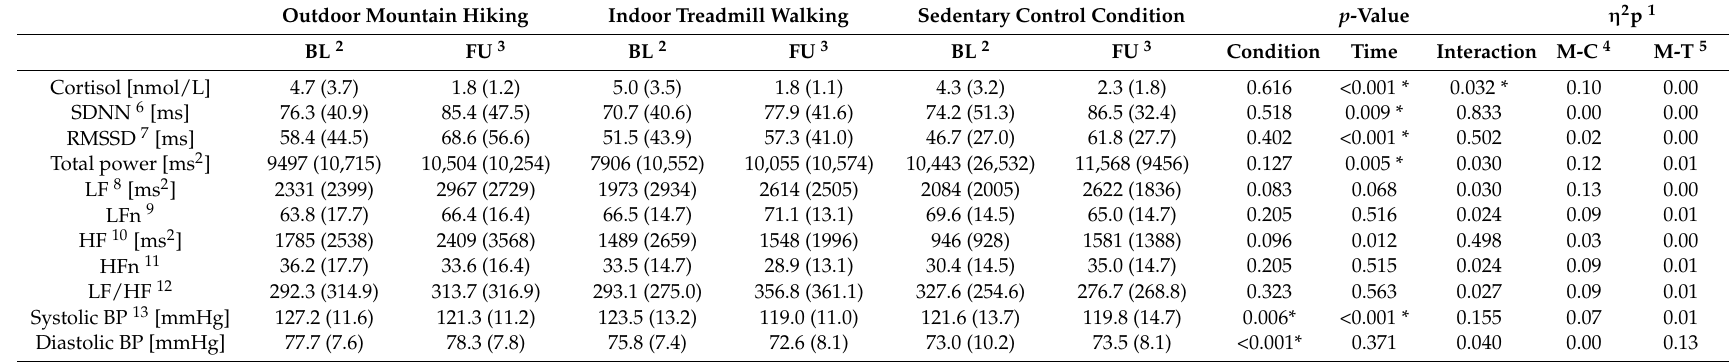
Table 2. Mean (SD) values for cortisol concentration and cardiovascular parameters from baseline (BL) to follow-up (FU) by condition. Outdoor Mountain Hiking Indoor Treadmill